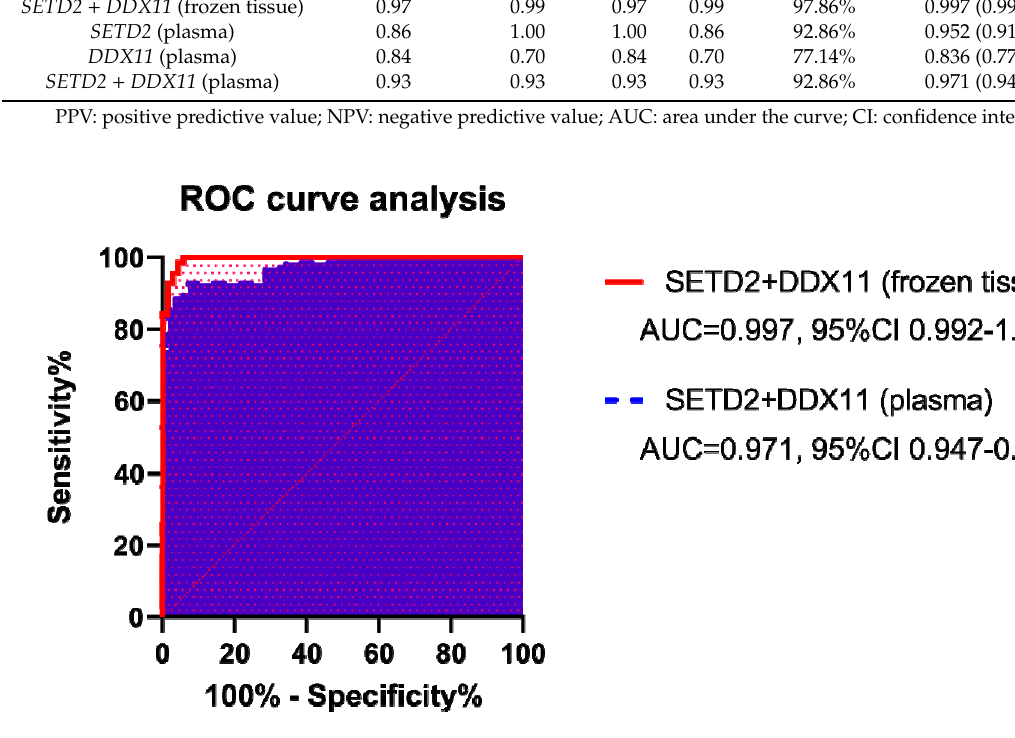
Figure 3. Receiver operating characteristic curves for the prediction models of high-grade clear cell renal cell carcinoma. The area under the curve was 0.997 (95% confidence interval (CI): 0.992–1.000) for SETD2 and DDX11 mRNA in frozen tissue, and 0.971 (95% CI: 0.947–0.994) in plasma.